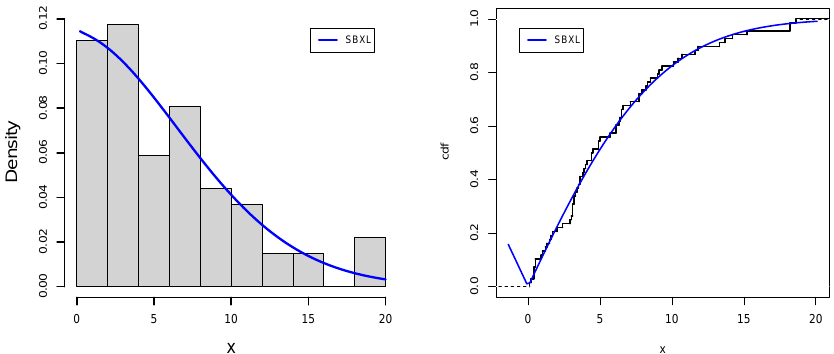
Figure 8. Plots of estimated pdf and cdf of the SBXL model for data